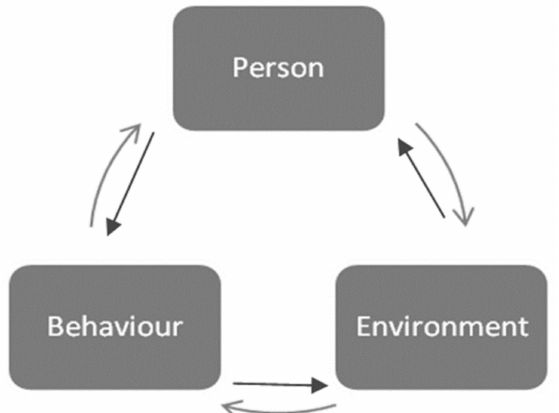
Figure 6. Structuration theory. Reproduced from Giddens, A., The Constitution of Society: Outline of the Theory of Structuration; published by University of California Press,